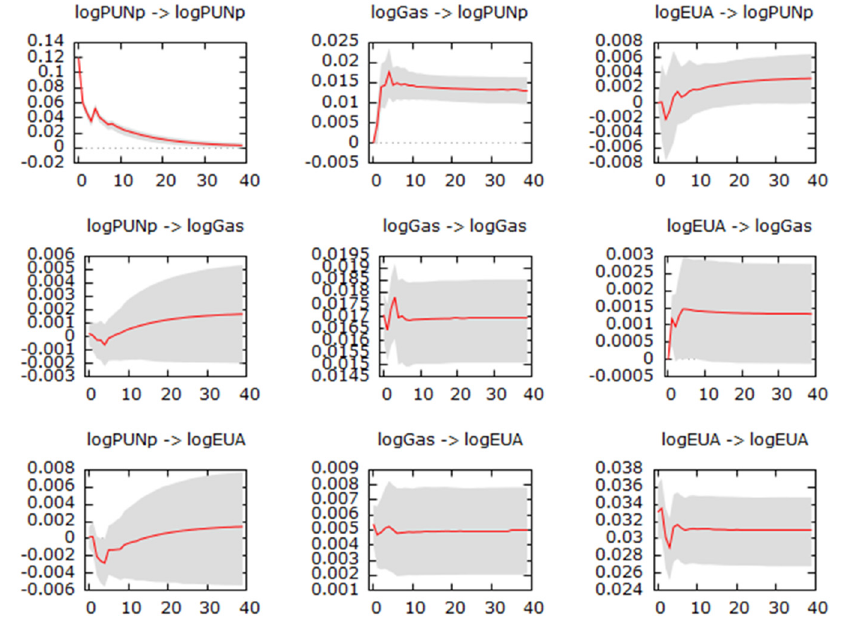
Figure A2. Impulse response functions of the VECM model (three variables, peak PUN, one cointegration relation). The shaded area represents the 90% confidence interval.